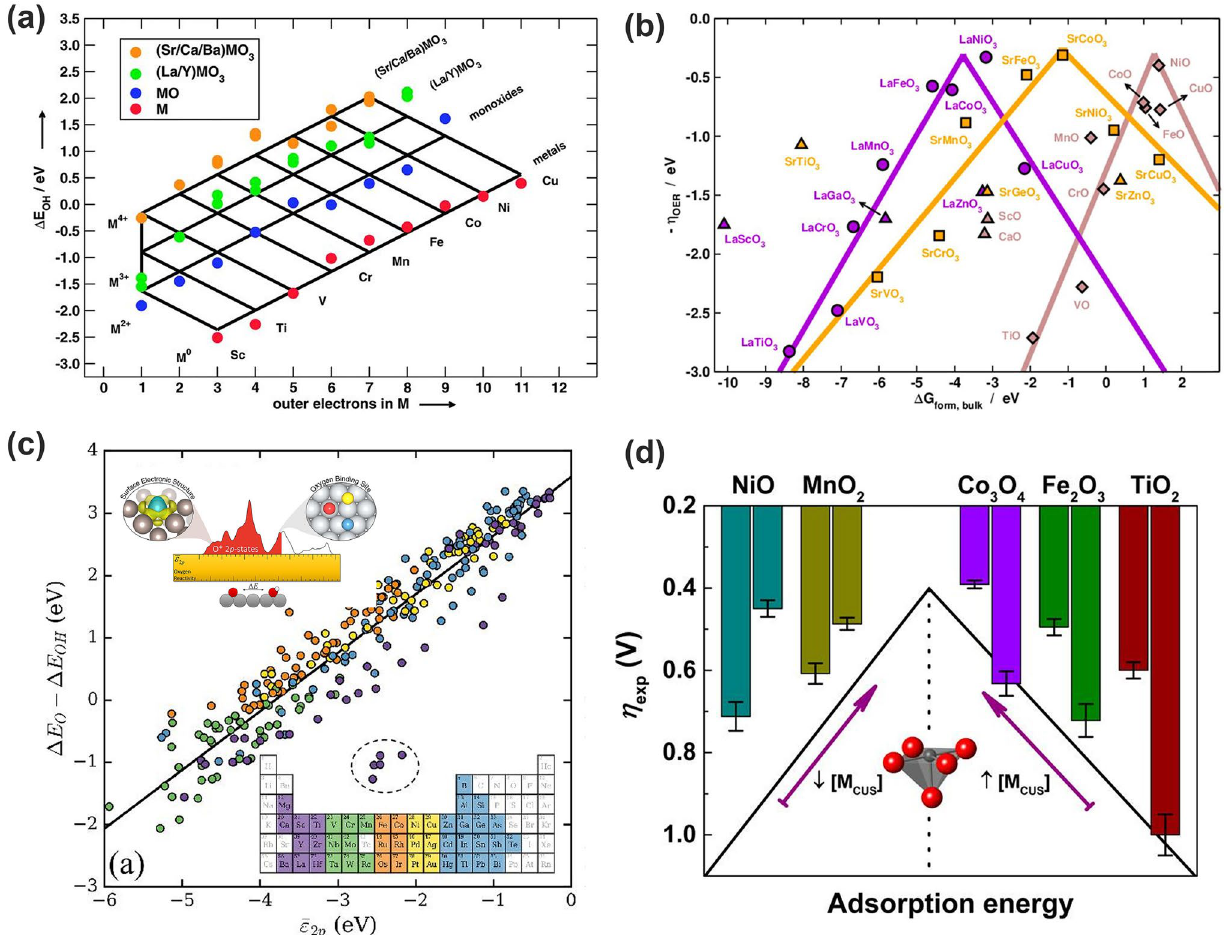
Fig. 8 Descriptors correlated with the oxygen electrolysis catalytic activity. a Adsorption-energy grid of *OH on metals (red), monoxides (blue), La/Y perovskites (green), and Sr/Ca/Ba perovskites (orange), as a function of the number of outer electrons [90]. Copyright © 2013 Royal Society of Chemistry. b Volcano-type activity plot for LaMO 3 (violet circles), SrMO 3 (orange squares), and MO (brown rhomboids) [93]. Copyright © 2015 American Chemical Society. c Correlation between 2 p and reactivity of surface oxygen atoms adsorbed at various metal and metal-oxide surfaces [94]. Copyright © 2019 Elsevier d Overview of the overpotential dependence on surface M CUS for TMOs. The η exp for